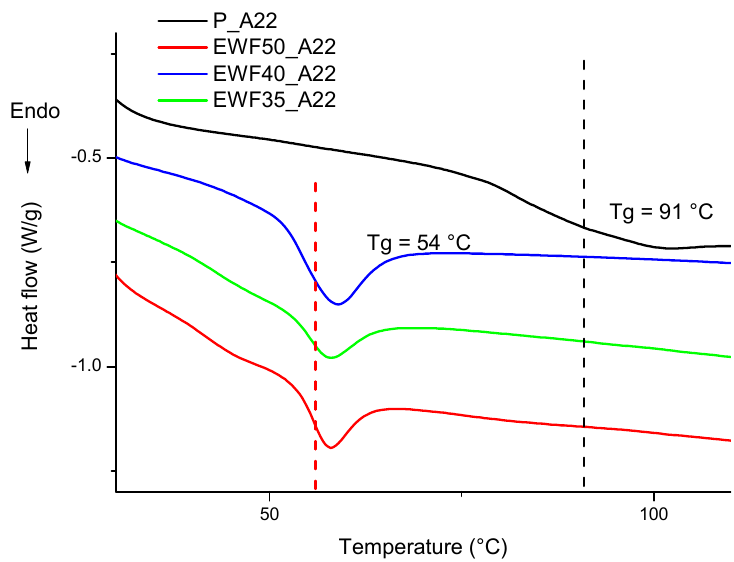
Figure 6. DSC analysis of postcured blends at different EWF contents.